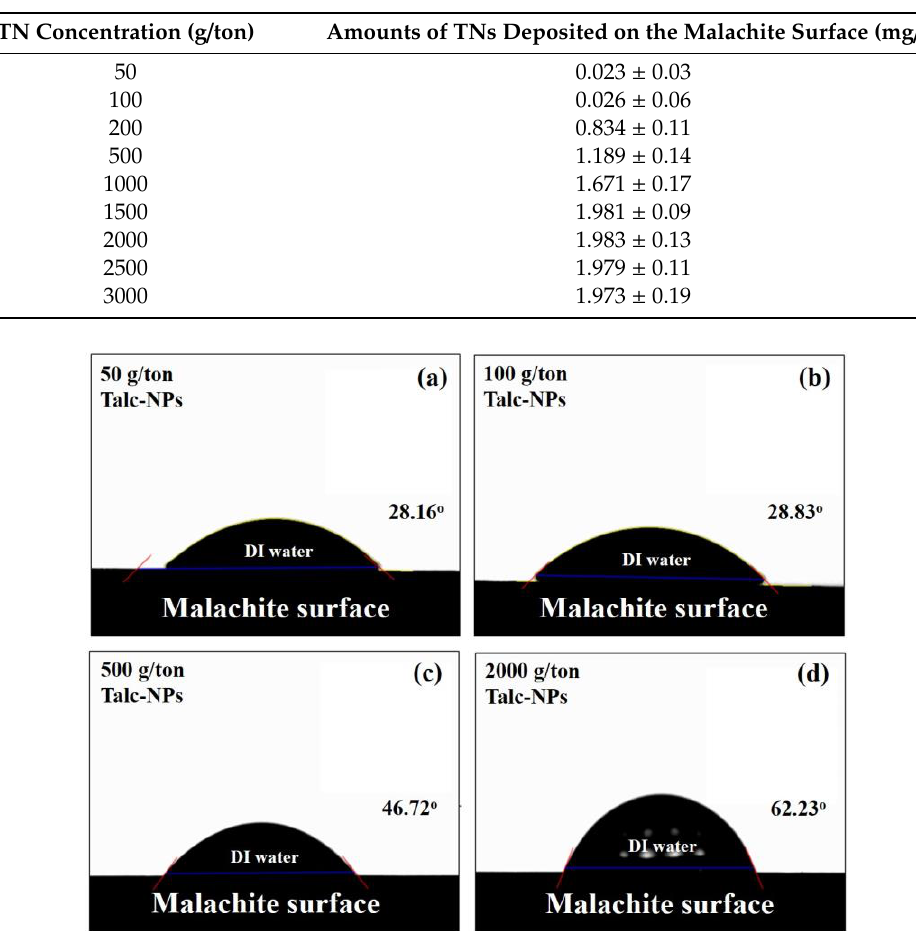
Table 3. The amounts of TNs deposited on the surface of malachite according to changes in TN concentrations. The absorbance tests were carried out at pH 6 using TN-2.